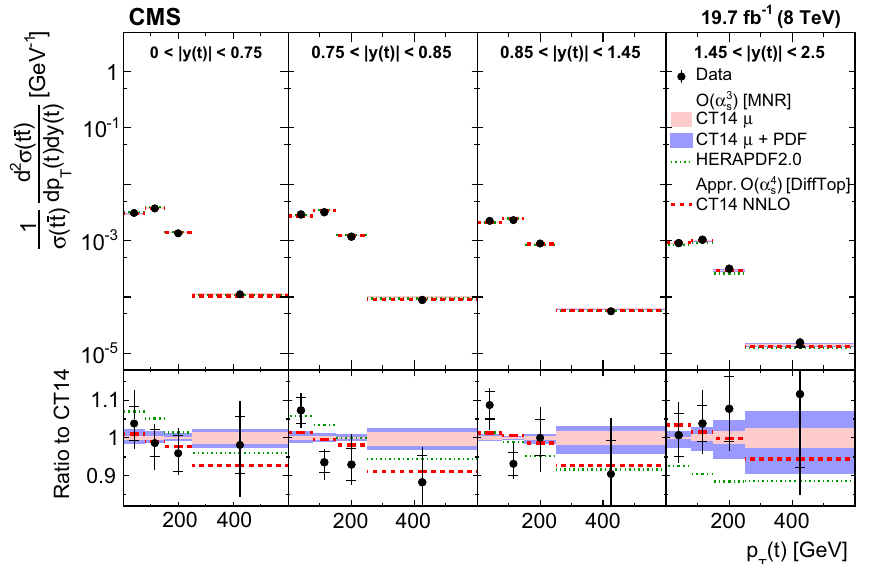
Fig. 8 Comparison of the measured normalized tt double-differential cross section as a function of p T ( t ) in different | y ( t ) | ranges to NLO O (α 3 s ) (MNR) predictions calculated with CT14 and HERAPDF2.0, and approximate NNLO O (α 4 s ) ( DiffTop ) prediction calculated with CT14. The inner vertical bars on the data points represent the statistical uncertainties and the full bars include also the systematic uncertainties added in quadrature. The light band shows the scale uncertainties ( μ ) Fig. 9 Comparison of the measured normalized tt double-differential cross section as a function of | y ( t ) | in different M ( tt ) ranges to NLO O (α 3 s ) predictions. Details can be found in the caption of Fig. 8. Approximate NNLO O (α 4 s